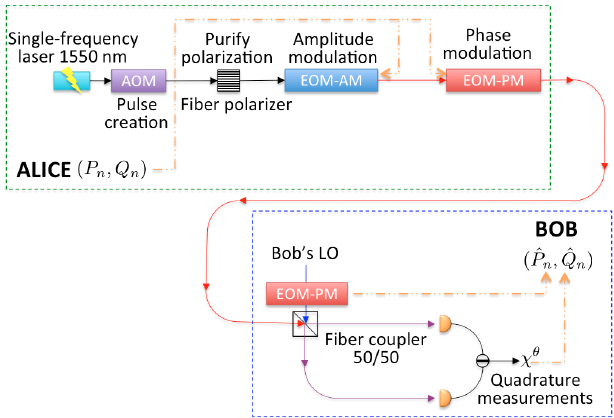
FIG. 1. Hardware schematic for the SR-CV-QKD protocol. In contrast to conventional CV-QKD implementations (e.g., Ref. [10]), the hardware requirements are dramatically simplified due to elimination of LO